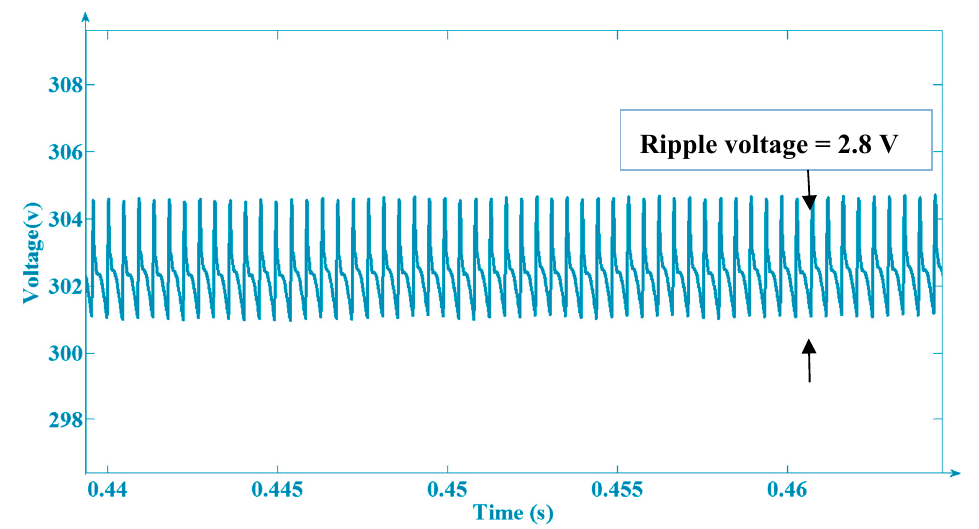
Figure 53. Output voltage ripple waveform for hybrid controller-4-based BDC.